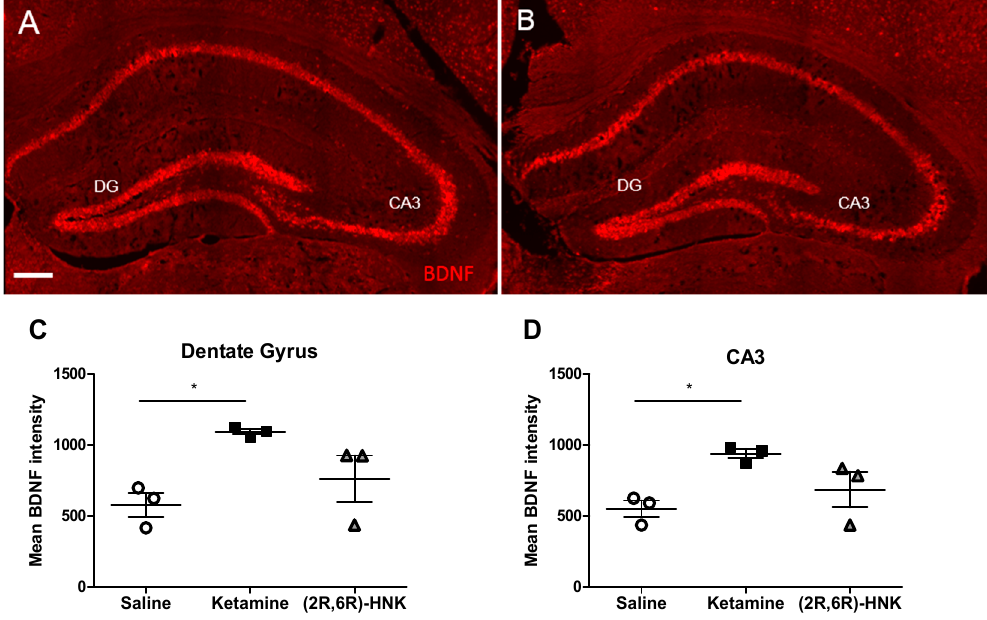
Figure 4 . Bdnf mRNA expression in the hippocampal DG and CA3 after a single injection with ketamine or (2R,6R)-HNK. ( A , B ) In situ hybridization with Bdnf probes on coronal sections showing the DG and CA3 region of the hippocampus of female Arc-CreER T2 × CAG-Sun1/sfGFP mice injected with ketamine ( A ) or (2R,6R)-HNK ( B ). Magnification 20×, scale bar represents 200µm. Ketamine but not (2R,6R)-HNK significantly increases Bdnf intensity in DG ( C ) and CA3 ( D ). (DG: one-way ANOVA, F (2, 6) = 5.991, p = 0.0371, followed by Bonferroni post-test, ketamine vs. saline: t = 3.415, df = 6, p < 0.05. CA3: one-way ANOVA, F (2, 6) = 5.754, p = 0.0402, followed by Bonferroni post-test, ketamine vs. saline: t = 3.341, df = 6, p < 0.05). Mean Bdnf intensity is displayed in mean gray values, indicating Bdnf mRNA expression. Error bars represent ± SEM. N = 3 mice/group, 3 sections per animal. * p < 0.05.